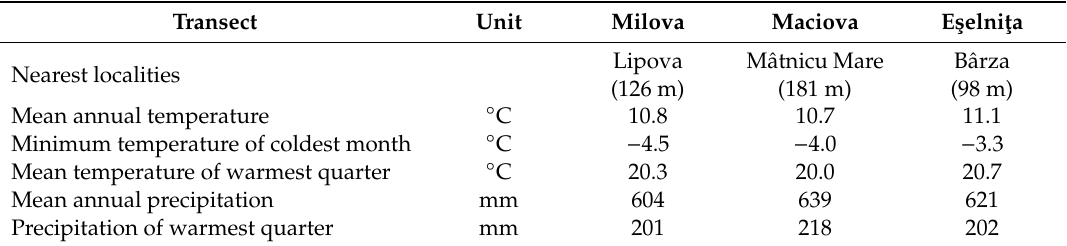
Table1. ClimatedataforthetransectsinMaciova, Milova, andE¸selni¸taaccordingtoclimate-data.org[34] using the nearest available localities.